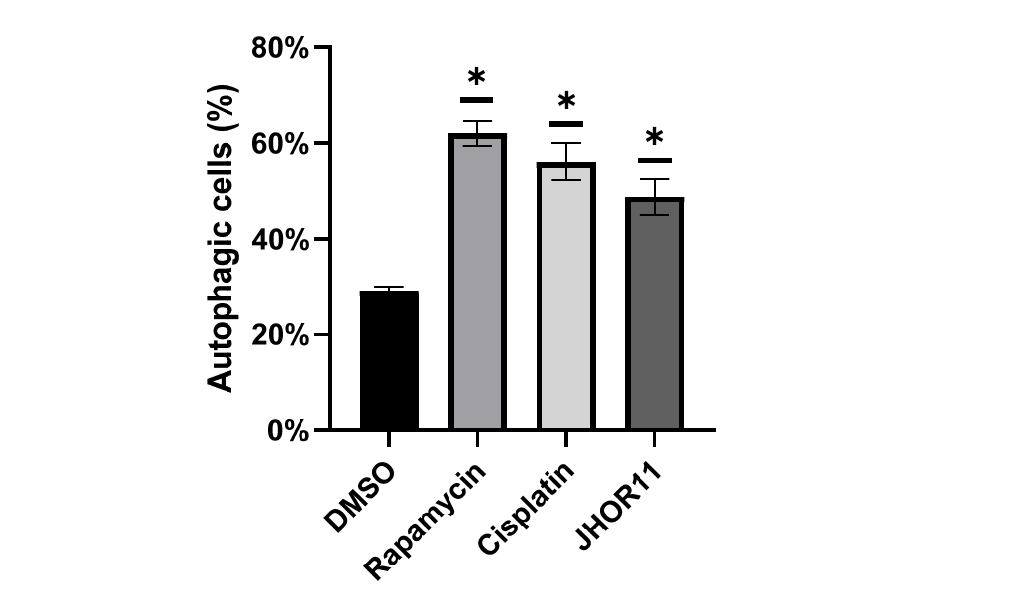
Figure 7. Percentage of autophagic cells after 48 h exposure of A2780 cells to IC 50 concentration of JHOR11, 0.1% ( v / v ) DMSO (vehicle control), 3.5 µ M cisplatin and 1.5 µ M rapamycin (positive controls). Bars represent the average ± SD of at least three independent experiments. * p value < 0.05 relative to vehicle control.